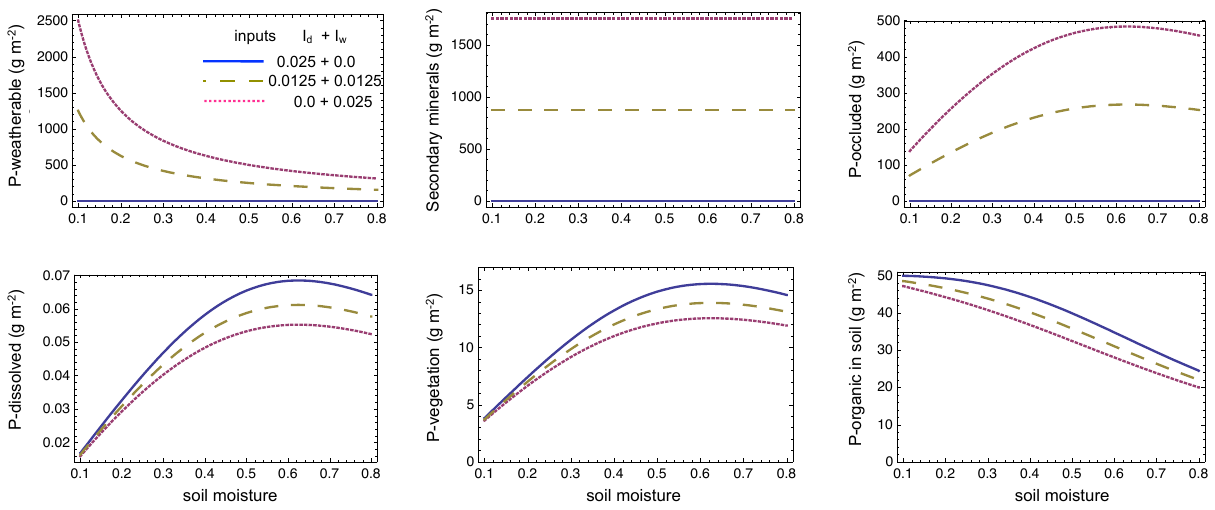
Fig. 2. Sensitivity of P external input to soil moisture. The dotted lines represent ecosystems depending only on uplift ( I w ), the solid lines represent ecosystem depending only on exogenous input ( I d ) and the dashed lines represent ecosystems depending on both, I w and I d . For these simulations we used the steady-state solution, presented in Eqs. (18)–(23). Refer to Table 2 for the parameters